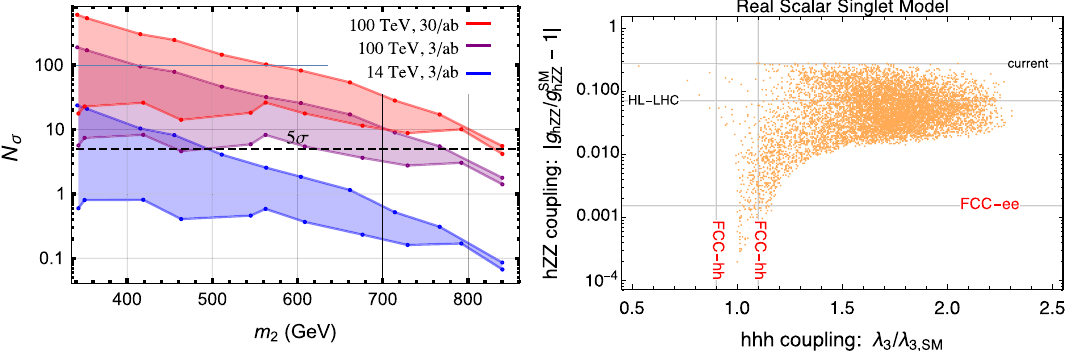
Fig. S.3 Manifestations of models with a singlet-induced strong first order EWPT. Left: discovery potential at HL-LHC and FCC-hh, for the resonant di-Higgs production, as a function of the singlet-like scalar mass m 2 . 4 τ and b ¯ b γγ final states are combined. Right: correlation